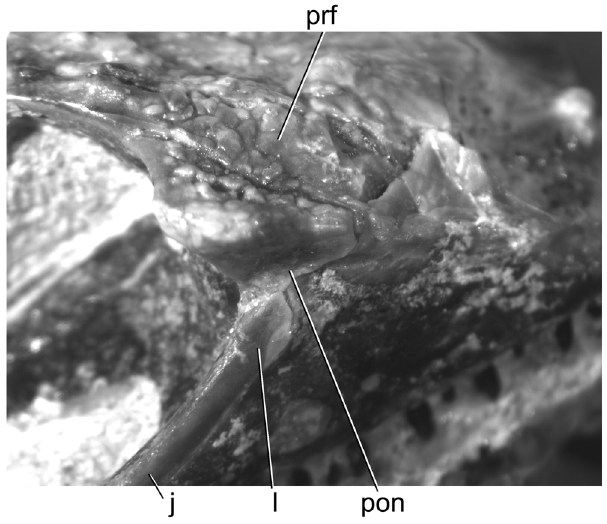
Fig 3. Right antorbital region of Babibasiliscus alxi nov. taxon (UWBM 89090) in dorsolateral view.